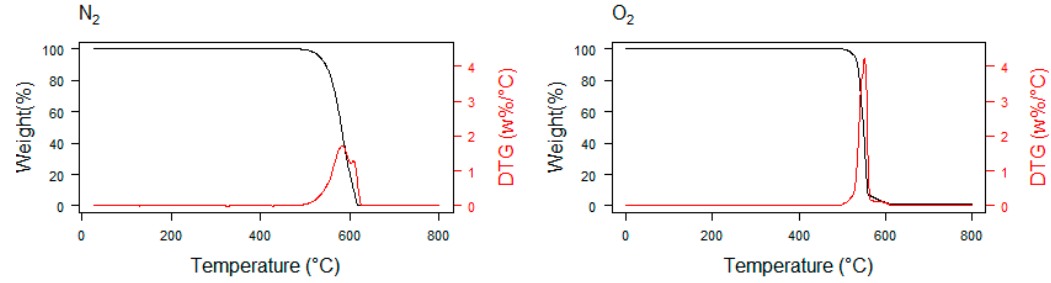
Figure 3. Decomposition of polytetraflourethylene (PTFE) in nitrogen (on the left) and in oxygen (on the right).